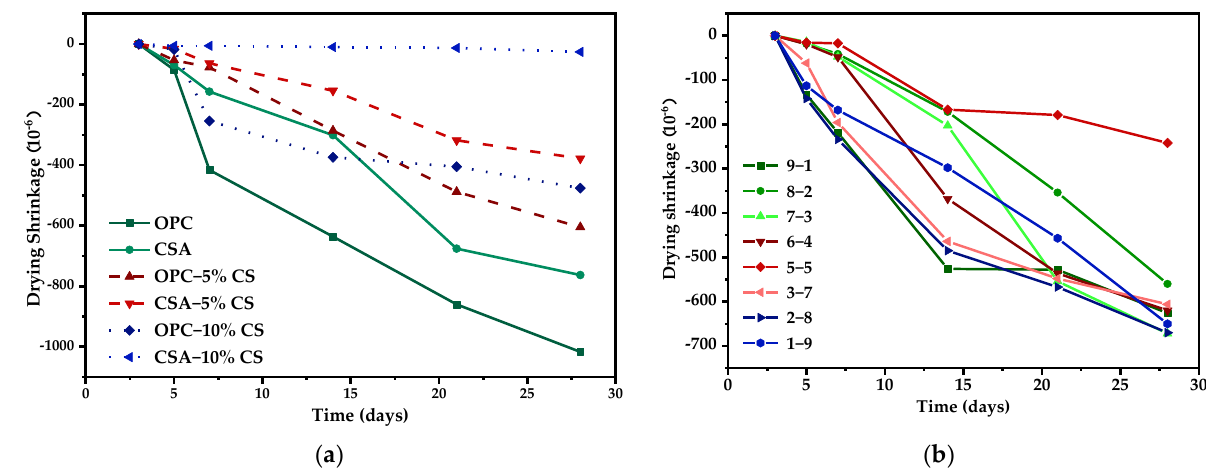
Figure 9. Drying shrinkage of unitary systems and binary systems: ( a ) OPC or CSA or OPC-CS or CSA-CS blends; ( b ) OPC-CSA blends.